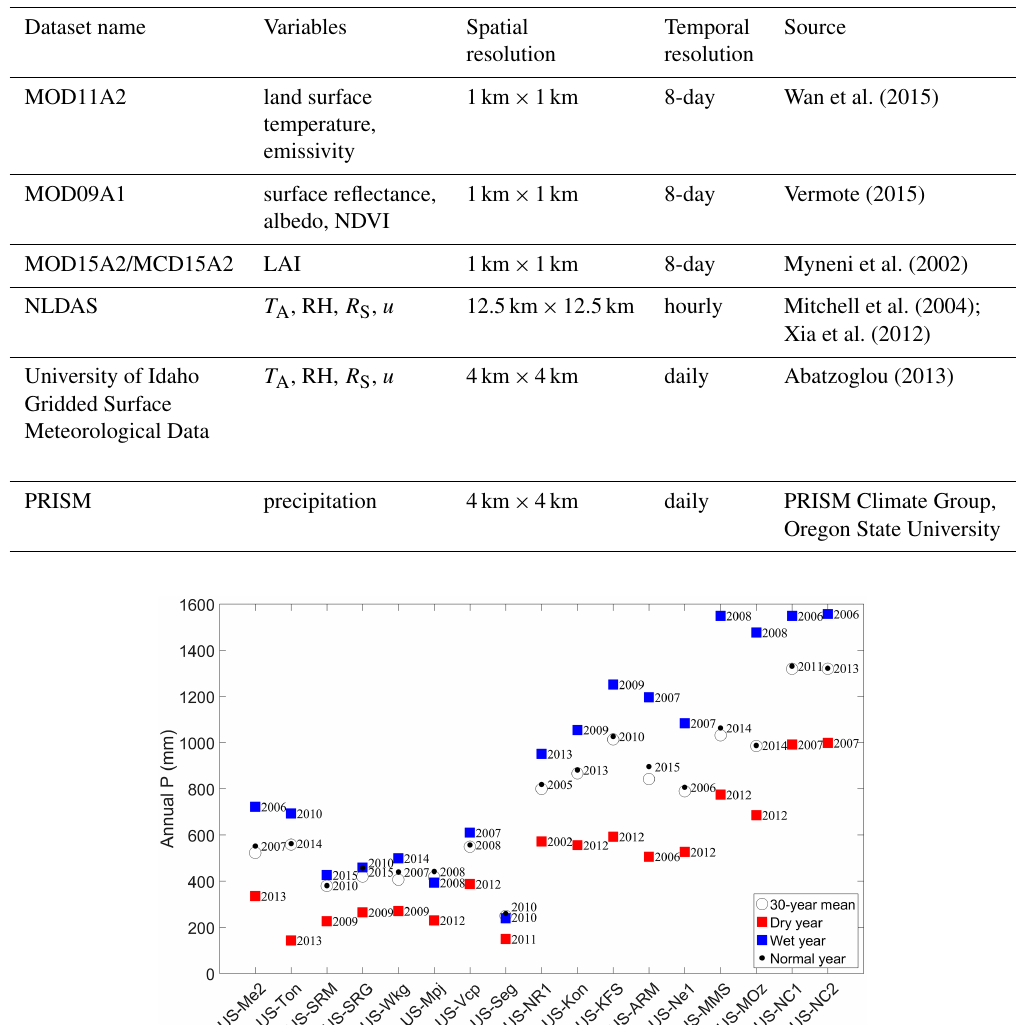
Table 2. Descriptions of MODIS and meteorological datasets used in this study.